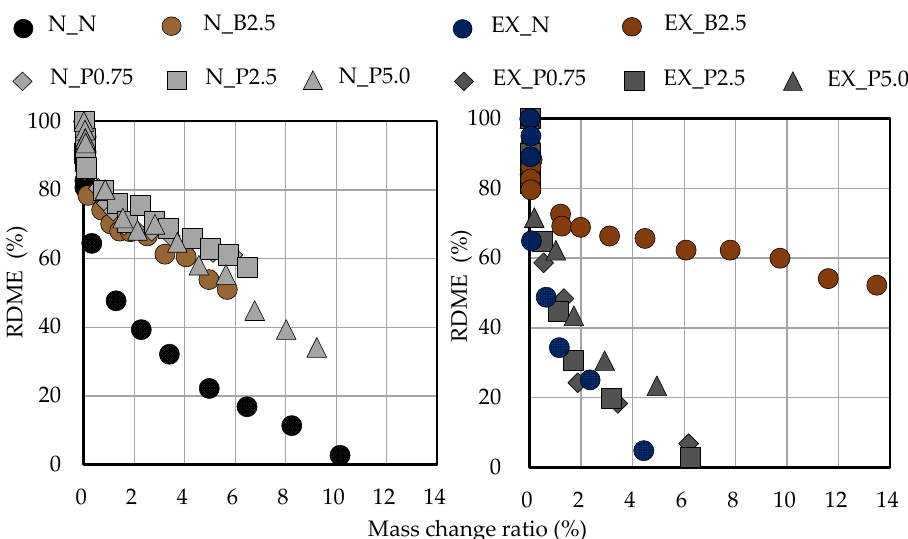
Figure 13. Relationship between RDME and the mass-reduction ratio in ordinary and expansive mortars. (black: without NFBC, brown: with NFBC type B f , grey: with NFBC type P f )